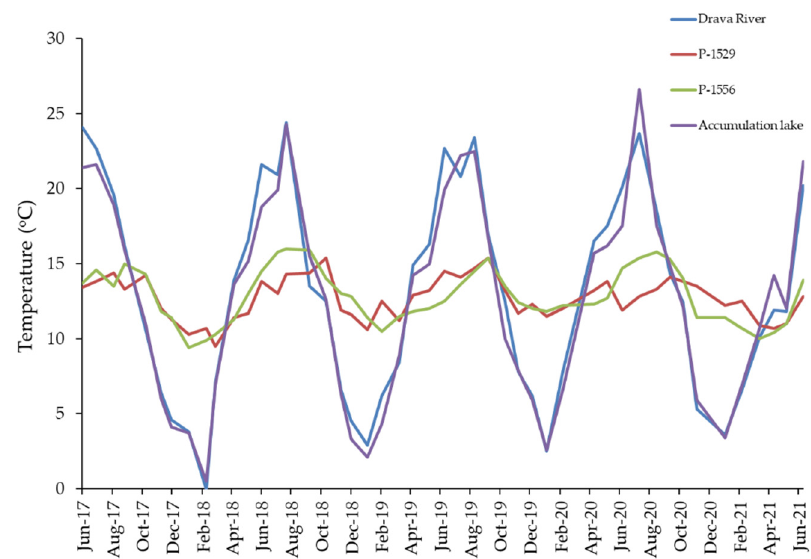
Figure 6. Surface and groundwater temperature oscillation in the monitored period.